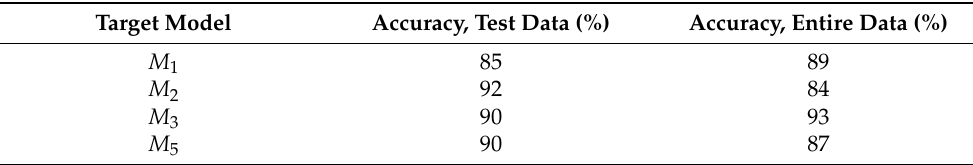
Figure 6. Confusion matrix at DL 18 (see Figure 1b): ( a ) M 1 , ( b ) M 2 , ( c ) M 3 , and ( d ) M 5 . Table 4. Accuracy results for coupled POD JDA–kernel, DL 18.